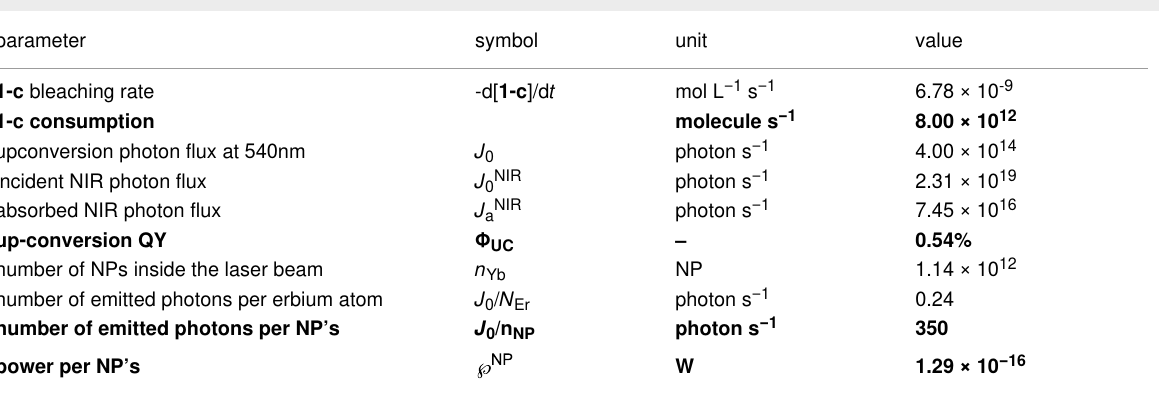
Table 2: Obtained